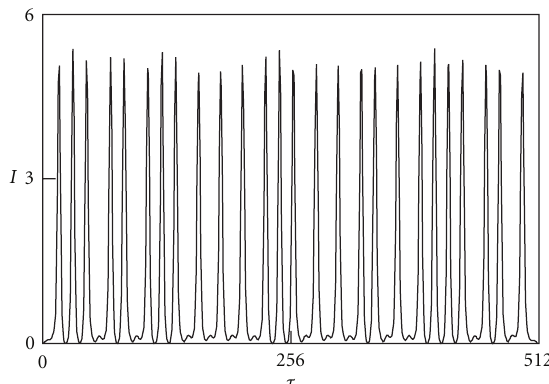
Figure 13: Stable molecule chain of bound solitons with the ground and first excited types of bonds in which the number 28062010 is coded in binary system 1101011000011000100111010. The greater distance between pulses corresponds to zero. The smaller distance between pulses does to unit. The laser parameters are the same as in the case of Figure 10.